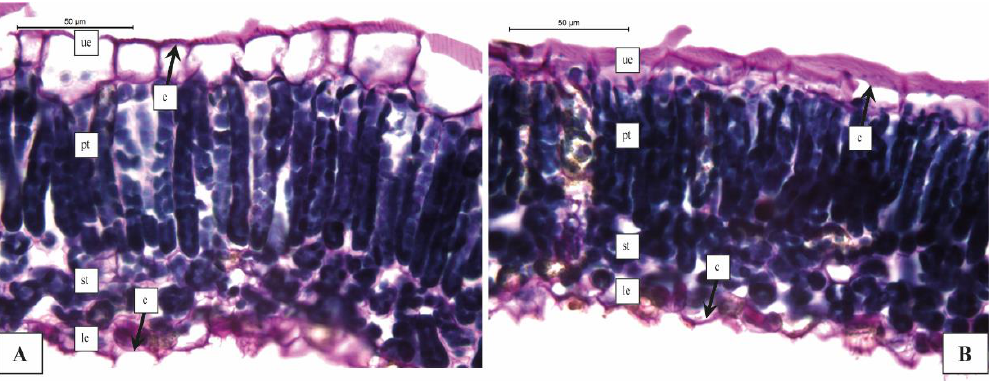
Figure 1. Transversal section of hop leaf cv. Cascade stained with PAS-Amido Black. ( A ) Untreat; ( B ) Treat 2. Legends: ue = upper epidermis; pt = palisade tissue; sp = spongy tissue; le = lower epidermis; c = cuticle thickness.